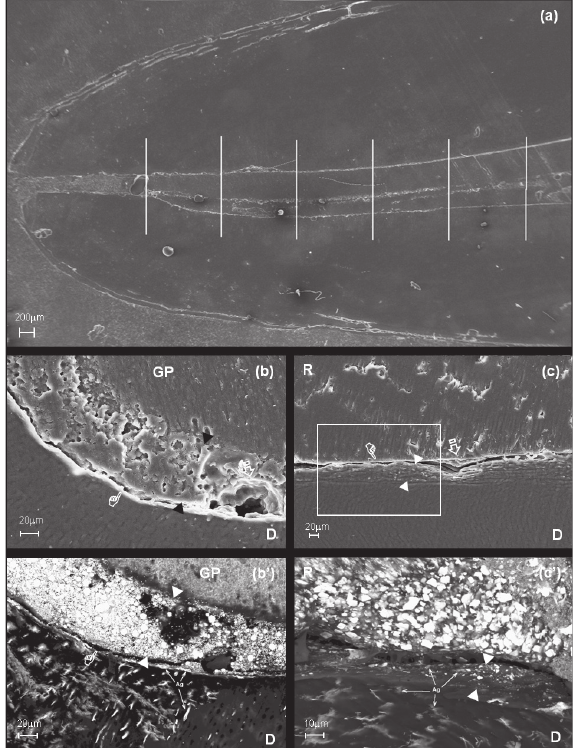
Figure 2- Scanning electron microscopy